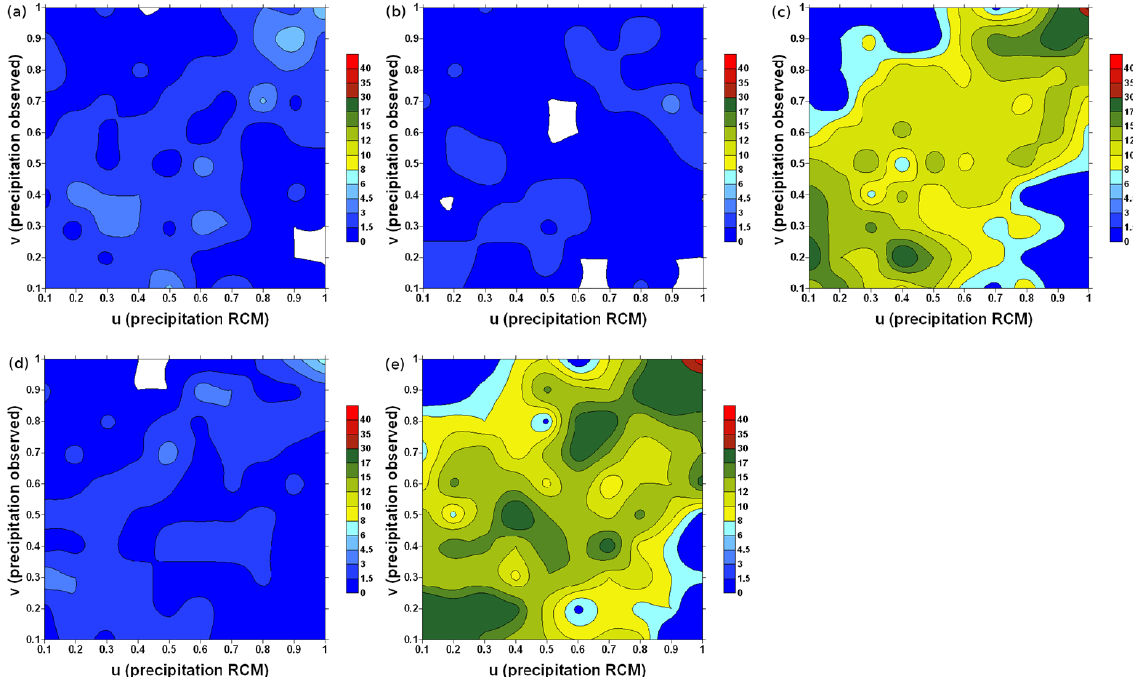
Fig. 9. Empirical Copula density for modelled ( u ) and observed precipitation ( v ) for Garmisch-Partenkirchen, using the weather type classi- fication following the advection of air masses. The advection types correpond to: (a) Northeast, (b) Southeast, (c) Southwest, (d) Northwest, and (e) no prevailing direction. The white areas originate from interpolation effects using an ordinary kriging